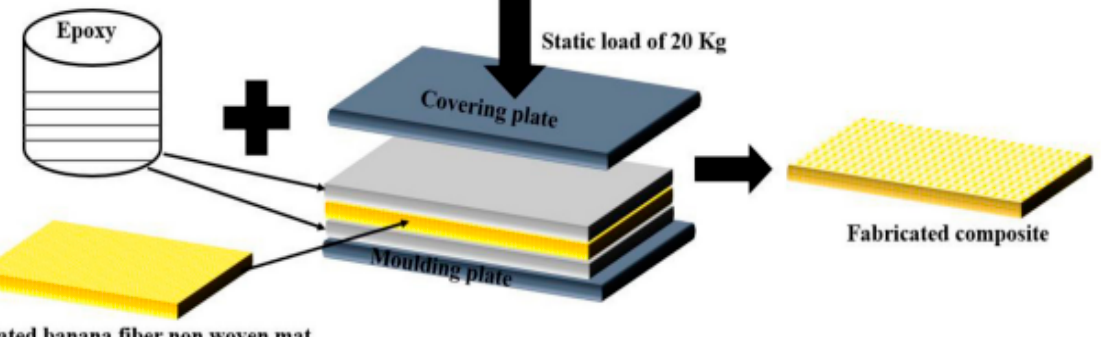
Figure 3. Preparation of woven banana epoxy-based composite [90] (Reprinted/adapted with permission from Elsevier Ref. 5457190666636 Copy right 2021).